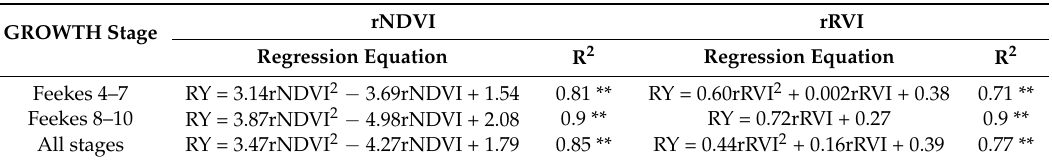
Table 6. Coefficient of determination between rNDVI, rRVI, and wheat yield at different stages in experimental fields across site-years.